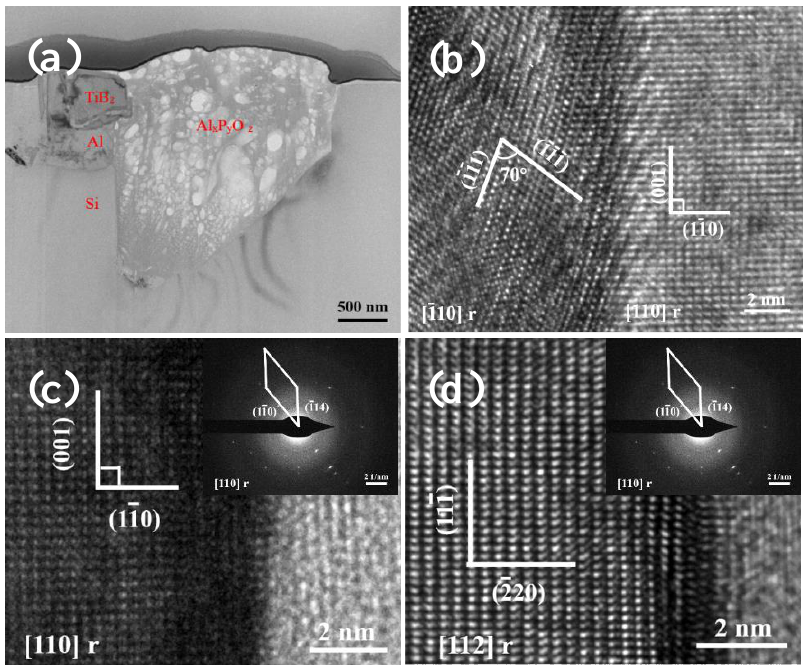
Figure 7. HRTEM diagram of interface in the primary Si ( a ) Section morphology of primary Si, ( b ) Al-TiB 2 interface, ( c ) TiB 2 -Al x P y O z interface, ( d ) Si-Al x P y O z interface.